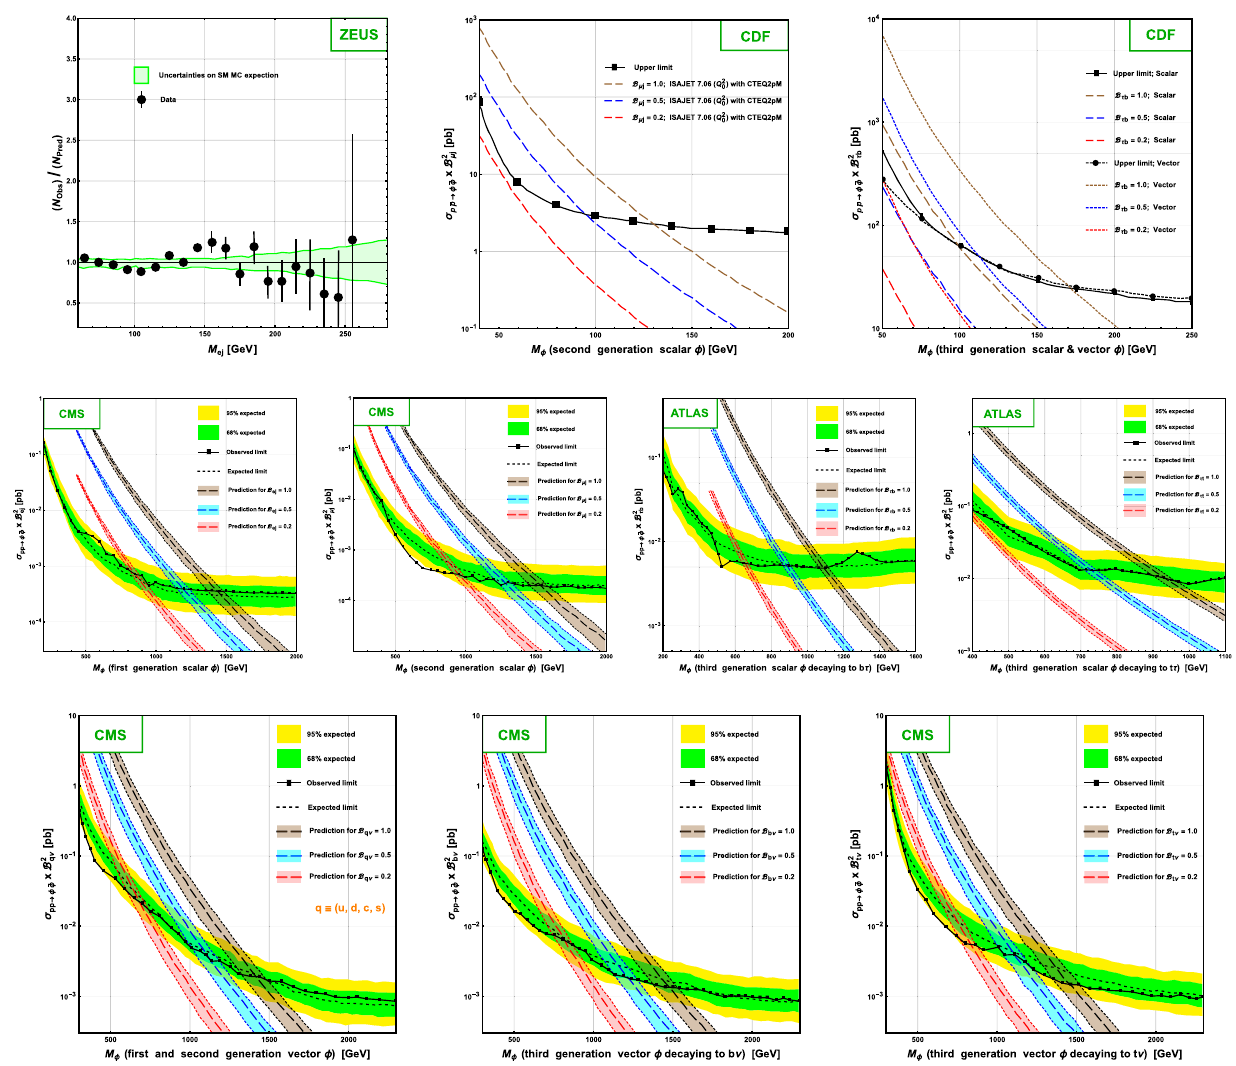
Fig. 2 Different experimental bounds on leptoquarks. The plots in the first row have been used for choosing the benchmark points for 70 GeV leptoquarks, the diagrams in the second row provide bounds on heavier